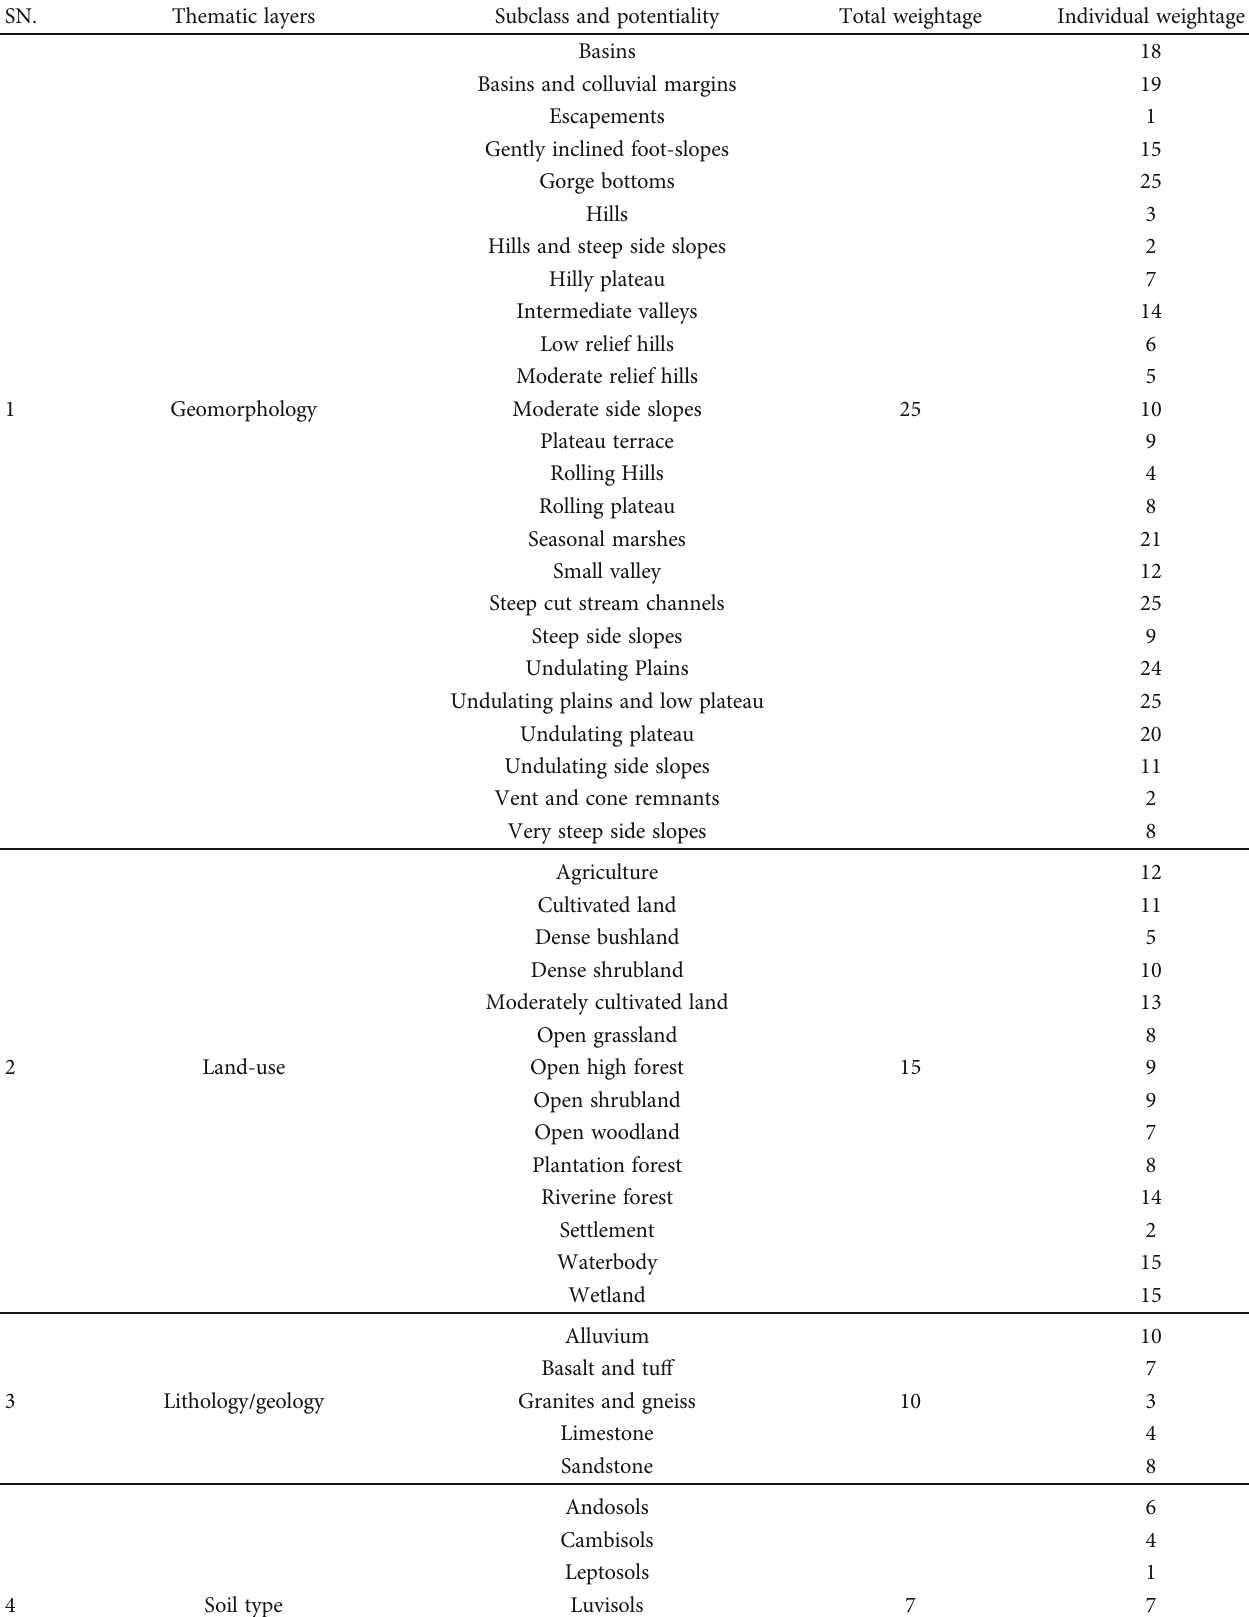
Table 2: Classi fi cation of weighted factors in fl uencing the potential zones in the study area.